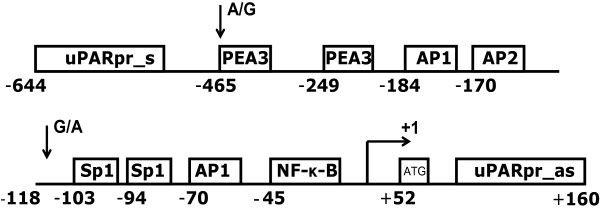
The uPAR promoter from -644 bp to +160 relative to the transcription start site with known regulatory sites and the two identified transitions.